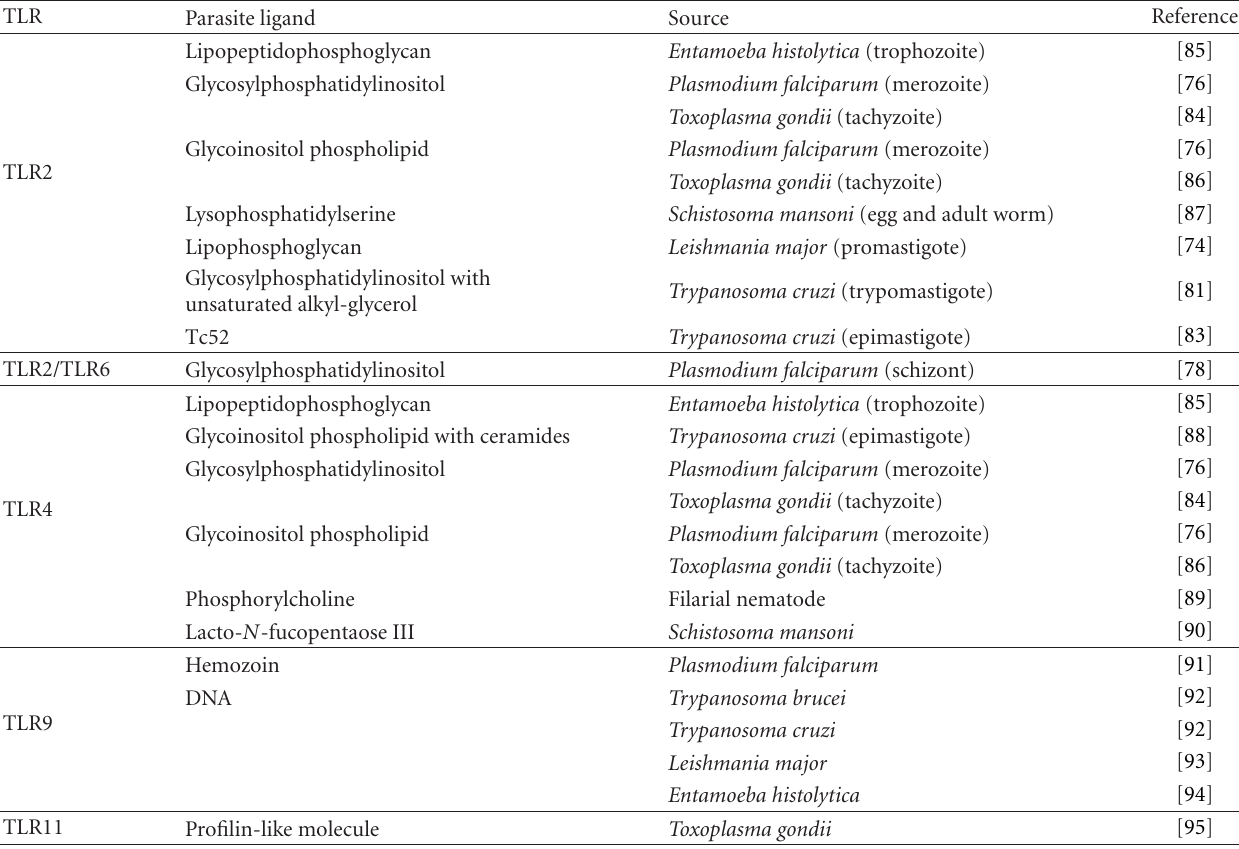
Table 2: TLR agonists from protozoan and helminth